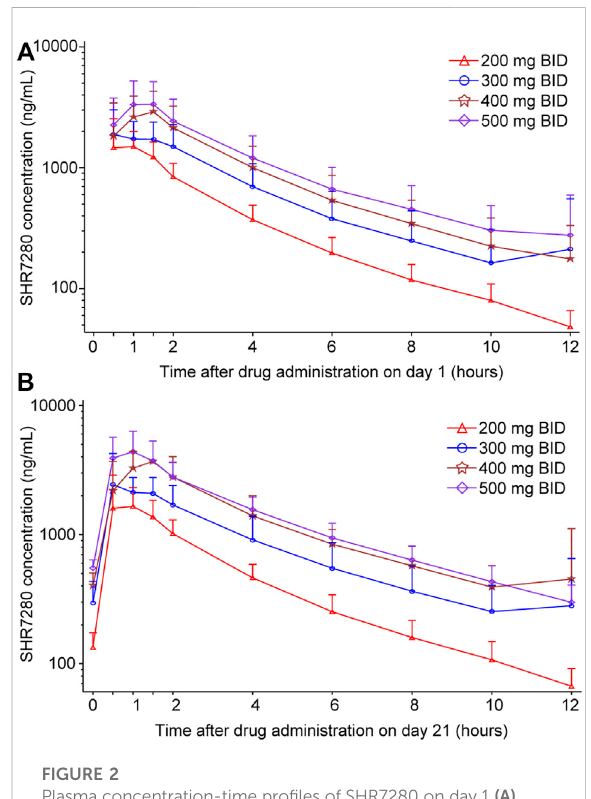
FIGURE 2 Plasma concentration-time pro fi les of SHR7280 on day 1 (A) and day 21 (B) . Data are presented as mean (±SD).